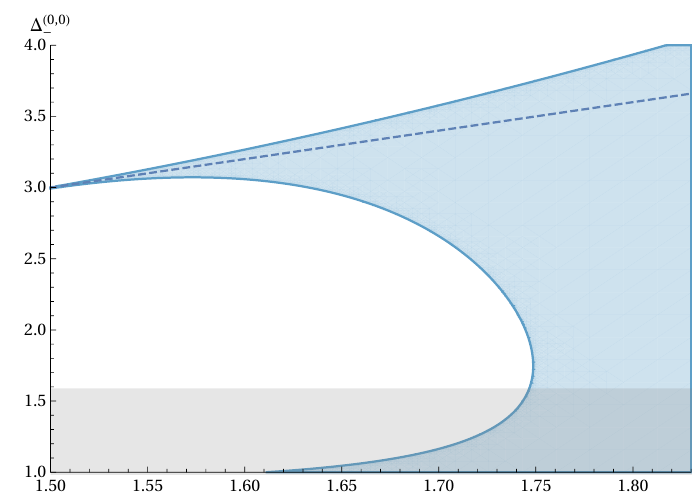
Figure 13 . Allowed values of the (cid:12)rst scalar charged operator assuming that the second charged scalar is irrelevant. The plot has been done at (cid:3) =